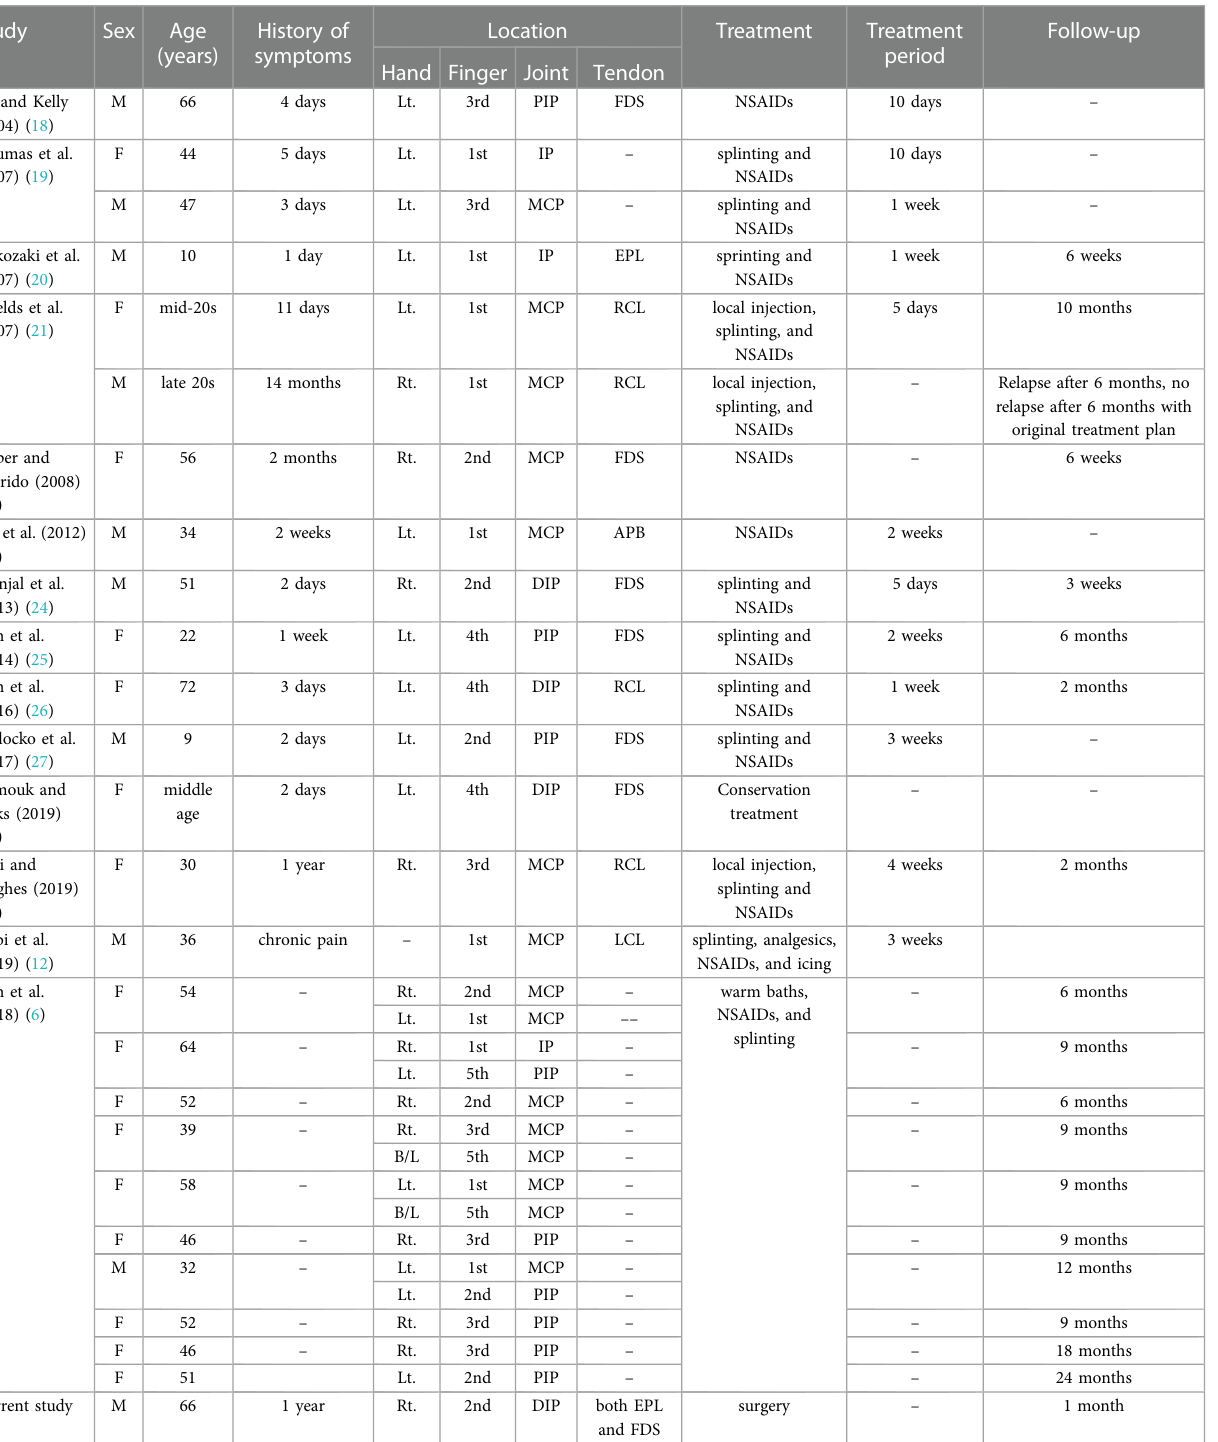
TABLE 1 Summary of the